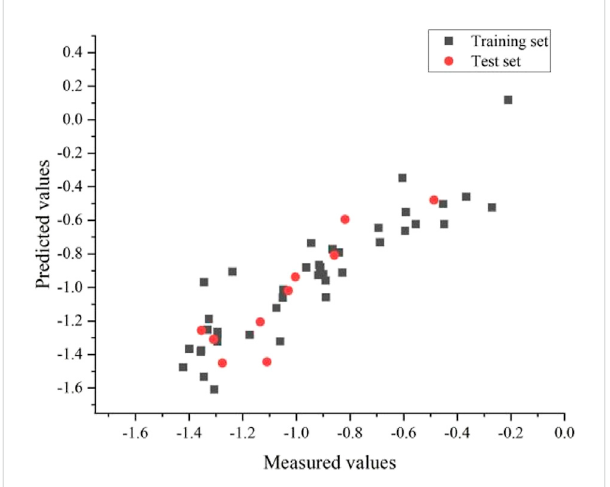
FIGURE 4 Plot of measured and predicted log(IC50) by